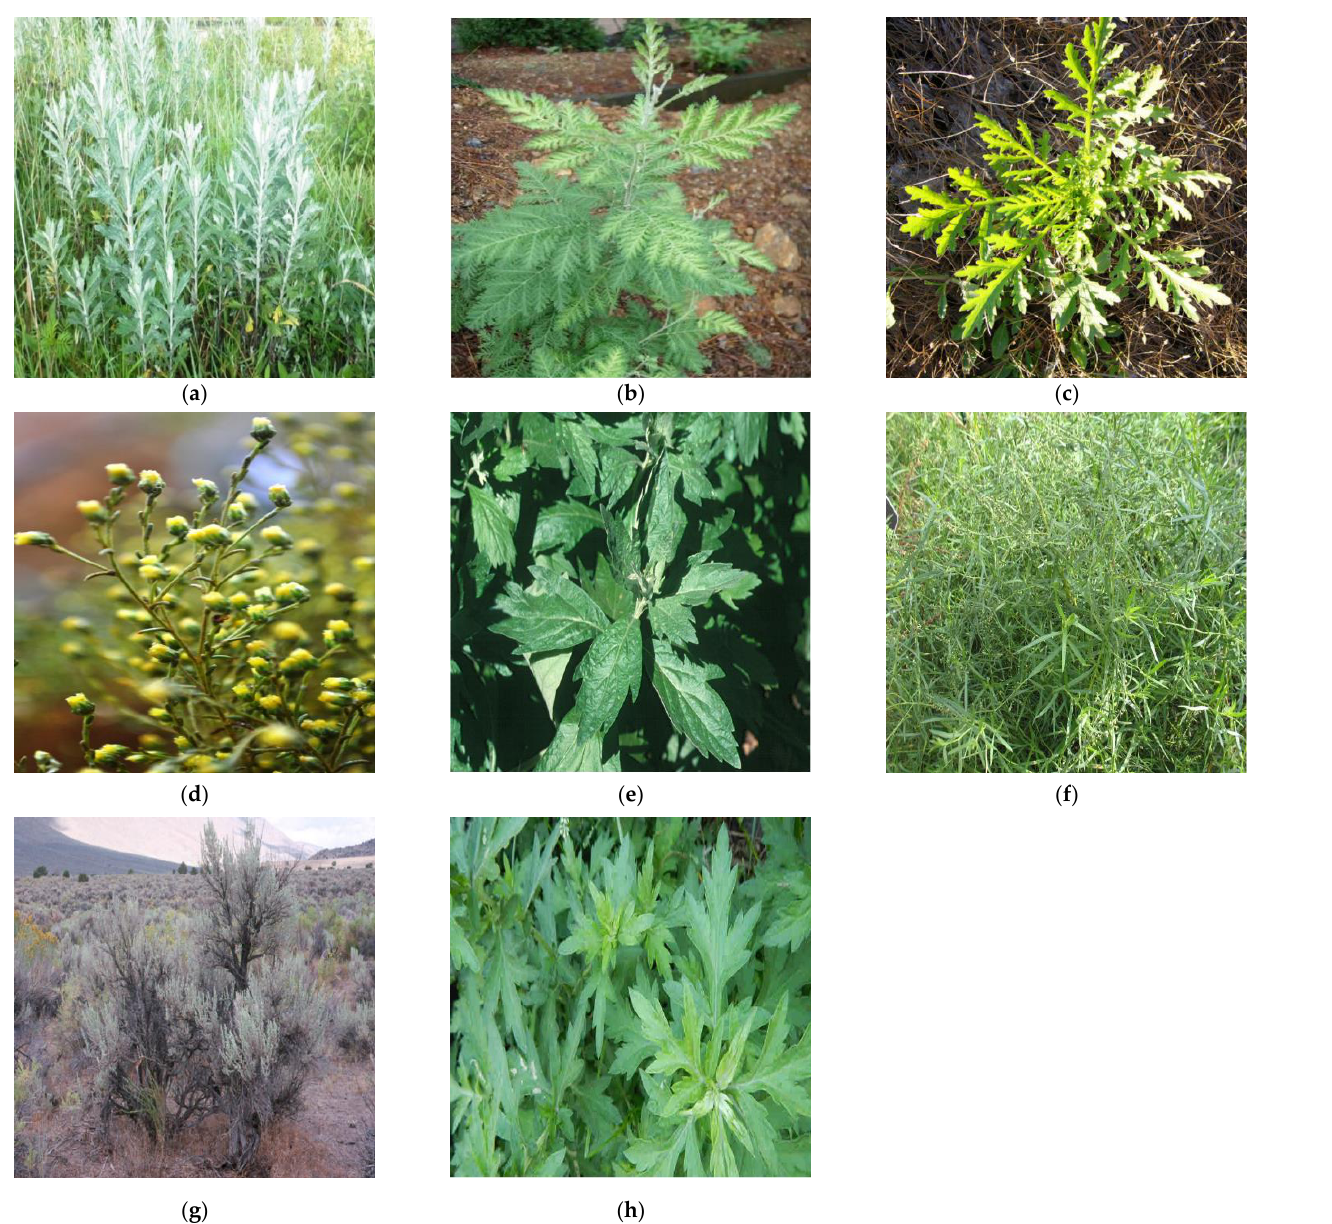
Figure 1. Field pictures of eight Artemisia species [6]: ( a ) Artemisia absinthium, ( b ) Artemisia annua, ( c ) Artemisia biennis, ( d ) Artemisia campestris, ( e ) Artemisia douglasiana, ( f ) Artemisia dracunculus, ( g ) Artemisia tridentata , and ( h ) Artemisia vulgaris .